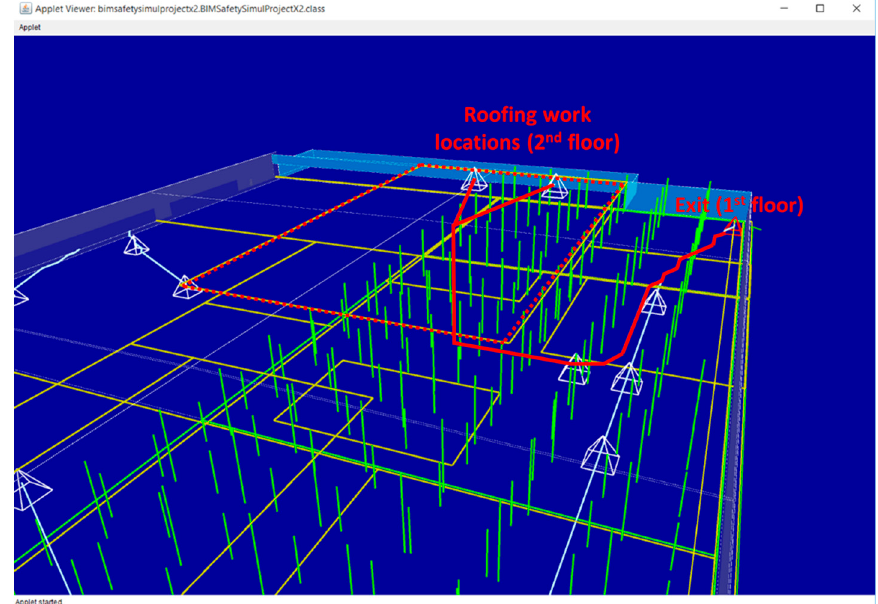
Figure 15. Scenario 2 ( a ) site condition, ( b ) navigation grid, ( c ) all available paths, and ( d ) selected paths.